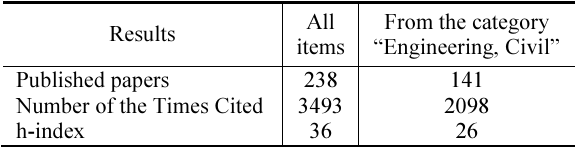
Table 1. Published and cited papers in ISI Web of Science database (assessed on the 1